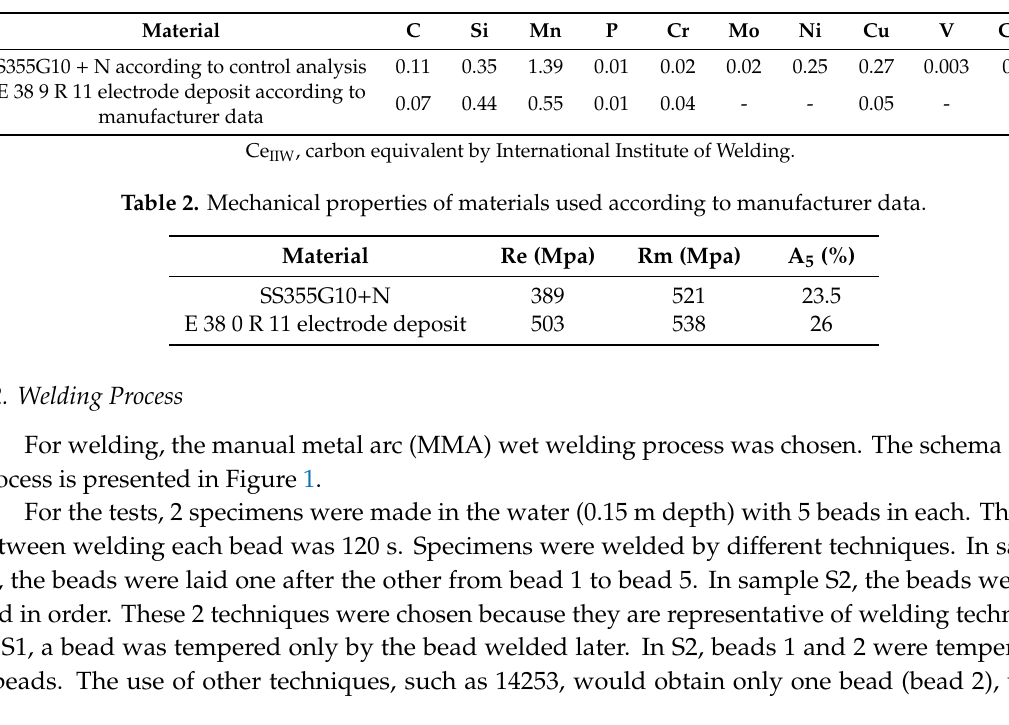
Table 1. Chemical compositions of materials used (wt.%).